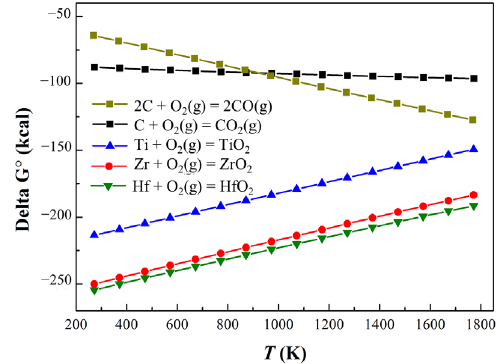
Fig. 14 Ellingham diagram of metal–O and C–O system (data calculated from HSC Chemistry 6